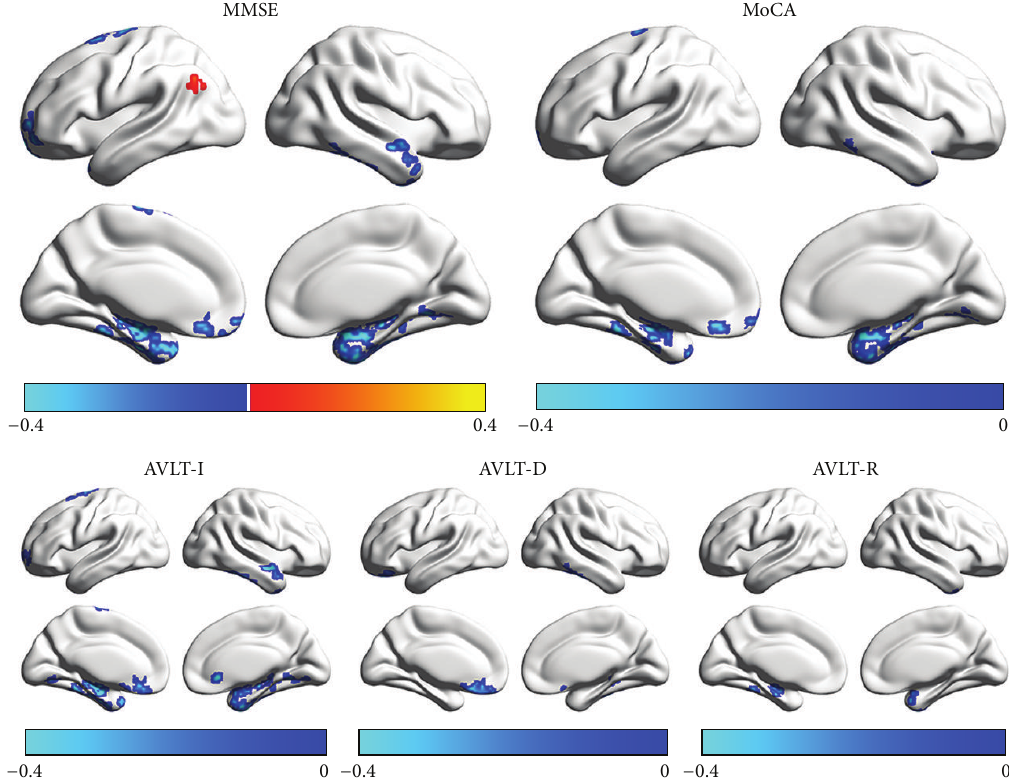
Figure 4: The correlation between FCS and neuropsychological scores in patients. The color bar represents the 𝑟 value. AVLT-I, auditory verbal learning test-immediate recall; AVLT-D, auditory verbal learning test-delayed recall; AVLT-R, auditory verbal learning test- recognition; MMSE, Mini-Mental State Examination; MoCA, Montreal Cognitive